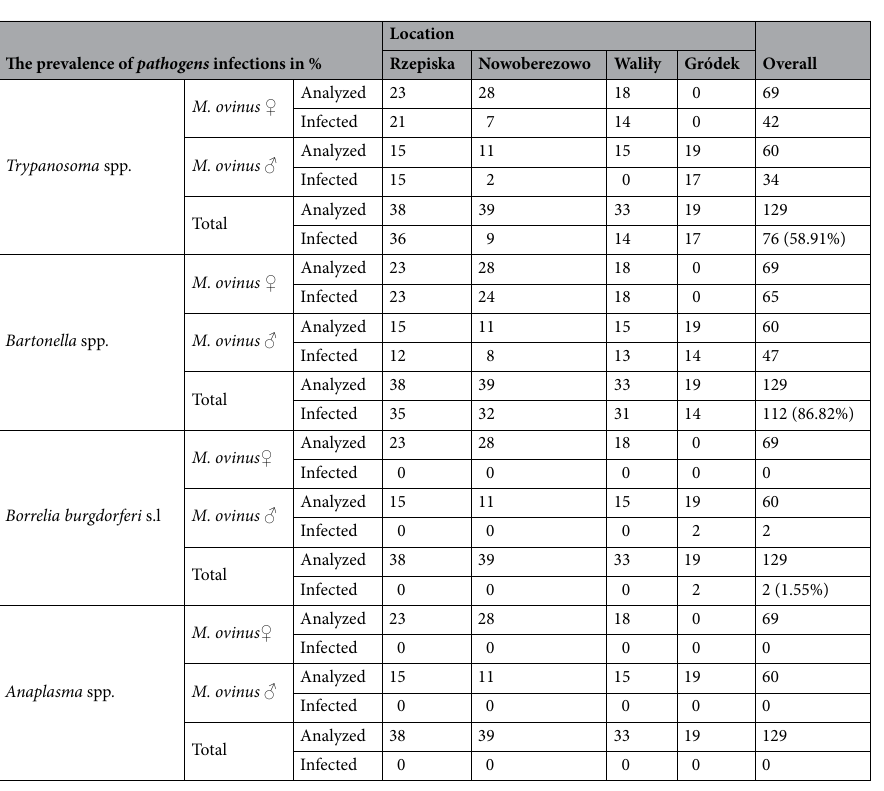
Table 1. Specimens of Melophagus ovinus analysed for Trypanosoma spp., Bartonella spp., Borrelia burgdorferi s.l. and Anaplasma phagocytophilum infection.